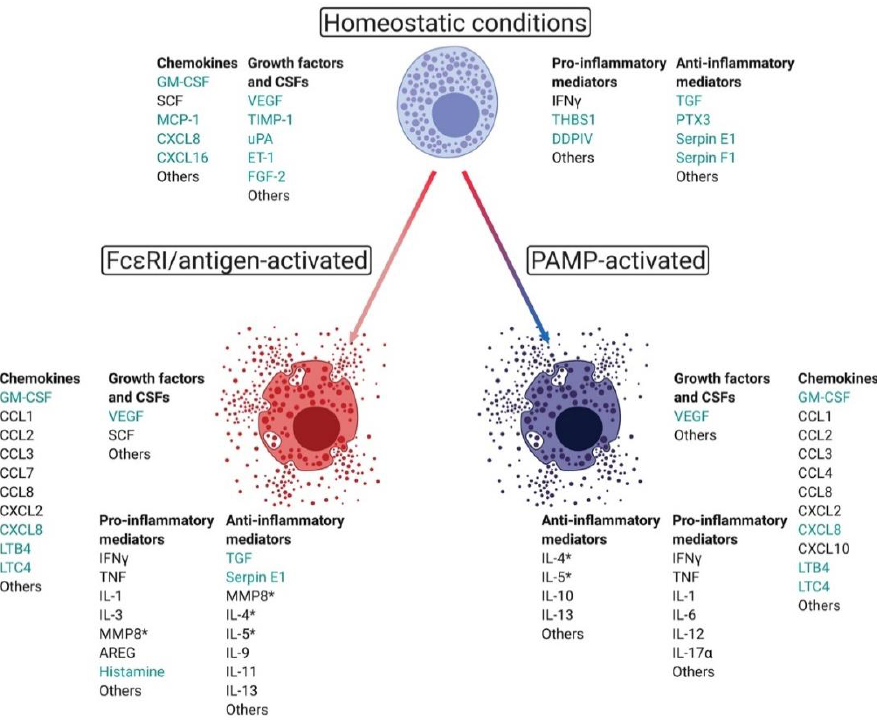
Figure 1. Human mast cell circuitry is programmed by host and environmental factors and is largely conserved in mice. Unstimulated mast cells are inherently pro-tumorigenic. Mast cells in homeostatic states release angiogenic mediators (teal font) such as VEGF, uPA, and MCP-1 that are able to promote tumor survival and progression. Mast cells activated by FcεRI/antigen-stimulation often adopt a less pro-tumorigenic phenotype and release a series of chemokines (CCL2, CCL3, CCL7, CCL8) that attract members of the mononuclear phagocyte system to tumor sites, where they amplify inflammatory responses. Additionally, PAMPs can program mast cells into anti-tumor effector cells capable of lysing tumors through TNF and IFN γ release and recruiting CD8 + T cells and NK cells to sites of tumors via mediators such as CXCL10 and CCL3, respectively. Moreover, effector mast cells release less angiogenic and pro-inflammatory mediators. Asterisks indicate both pro- and anti-inflammatory functions. Figure prepared in BioRender.